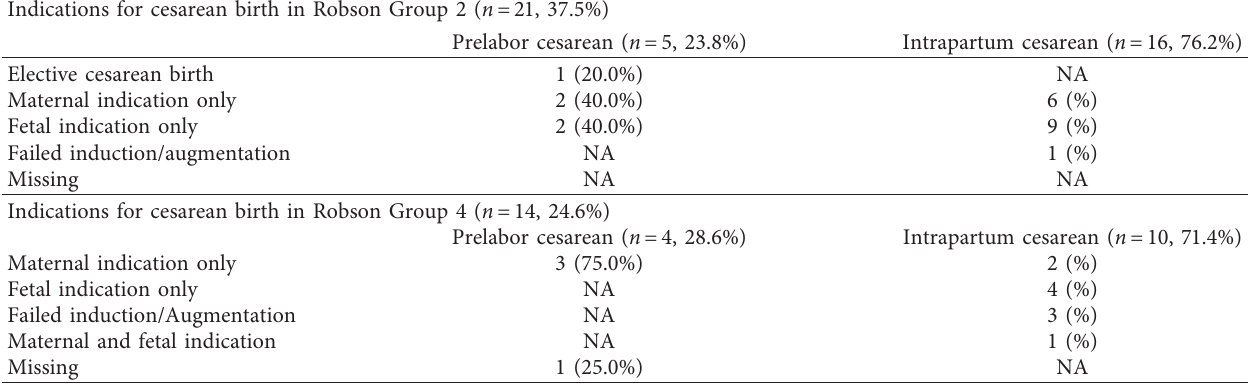
Table 1: Cesarean birth by indication in Robson Groups 2 and 4 at Mizan-Tepi University Teaching Hospital. Indications for cesarean birth in Robson Group 2 ( n � 21,